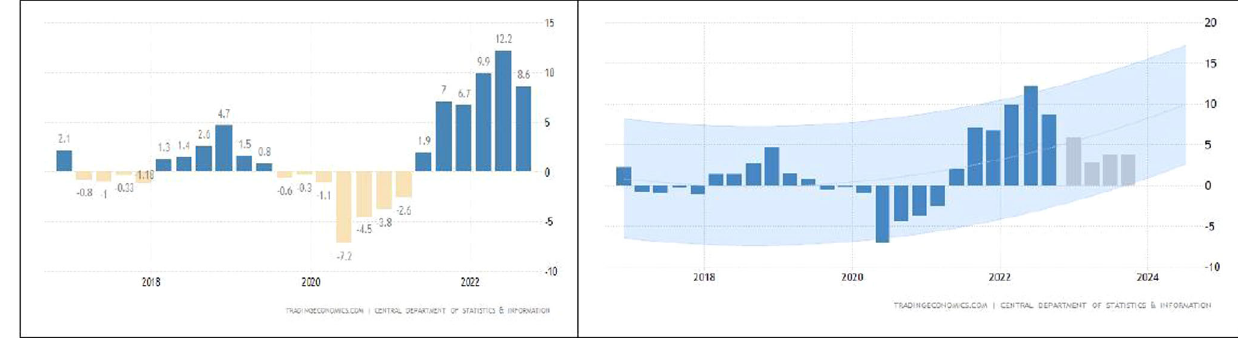
Fig. 1 The Gross Domestic Product (GDP) in Saudi Arabia Source: (Trading